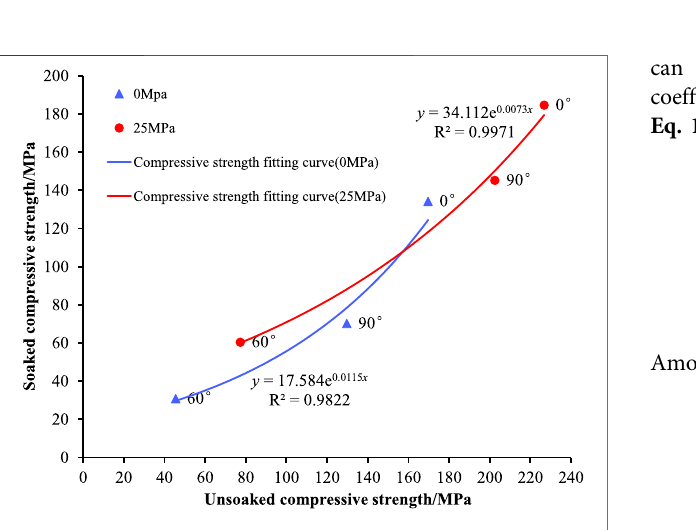
FIGURE 5 | Cohesion and angle of internal friction before and after immersion.